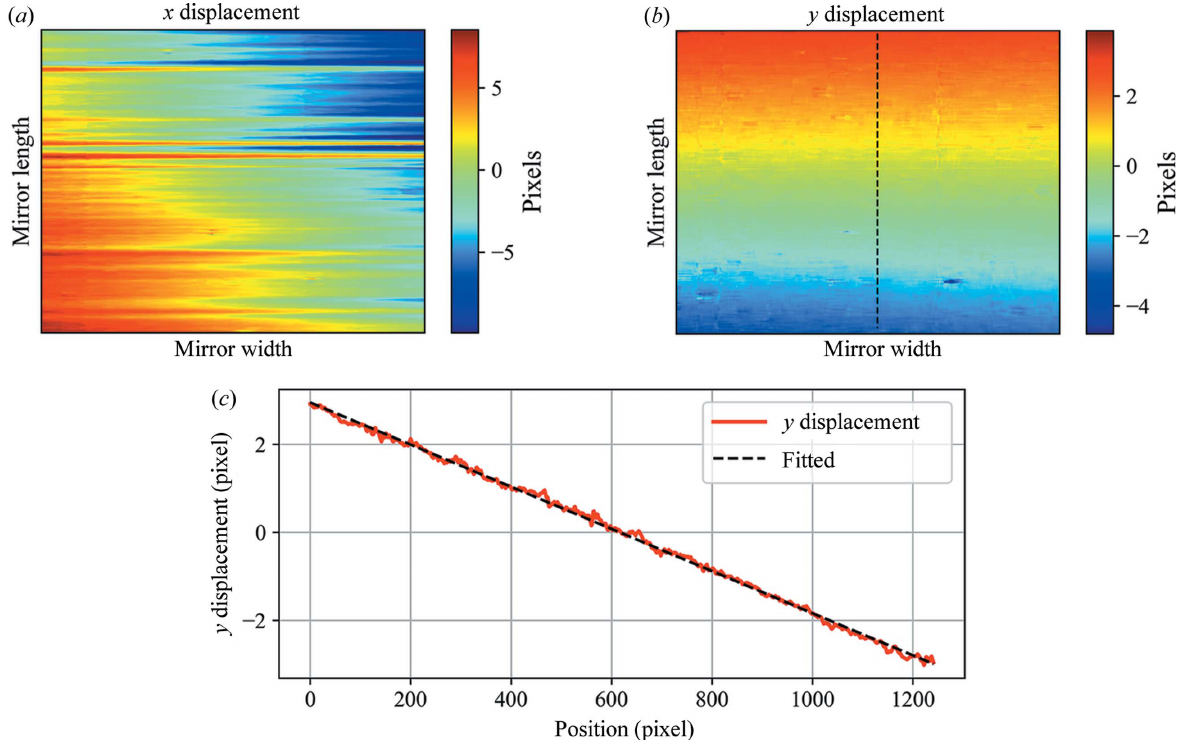
Figure 2 2D maps of the calculated displacements, without mirror misalignment correction, in the ( a ) x and ( b ) y directions. In the 2D maps the mirror width corresponds to the y direction and the mirror length corresponds to the x direction on the detector plane. The central line has been extracted from the 2D map of the y displacement ( b ) to give the 1D curve shown in ( c ). The x axis of ( c ) is the position along the mirror